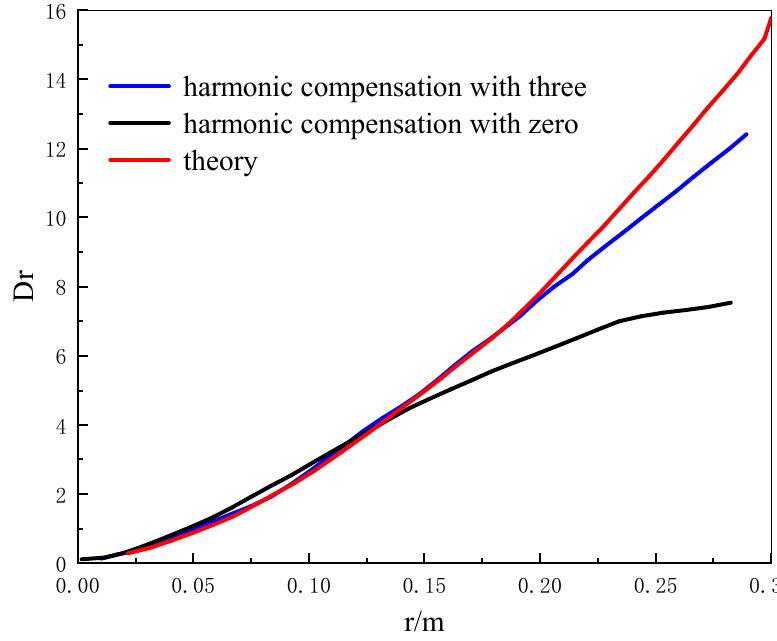
Figure 9. Kolmogorov phase screen structure function comparison diagram.